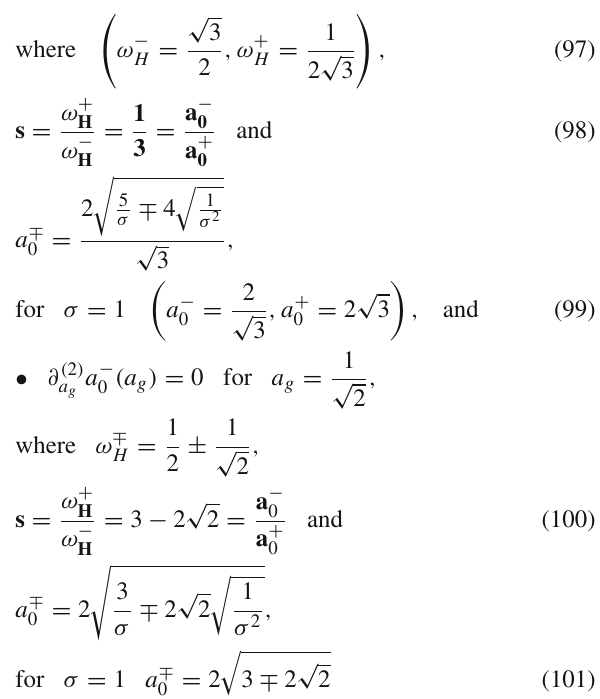
Fig. 24 Confinement of the inner horizon frequencies based on the analysis of Eq. (88). Left: limiting spins a ± c as functions of r / M . Cen- ter: limiting frequencies ω ± c as functions of r / M and a / M . Right: plane